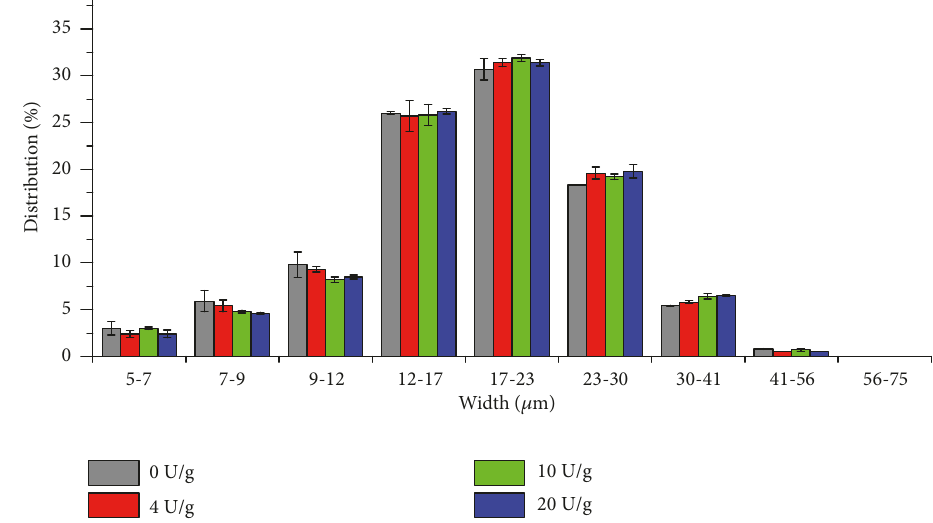
Figure 6: Effect of xylanase treatment on the width distribution of refiner mechanical